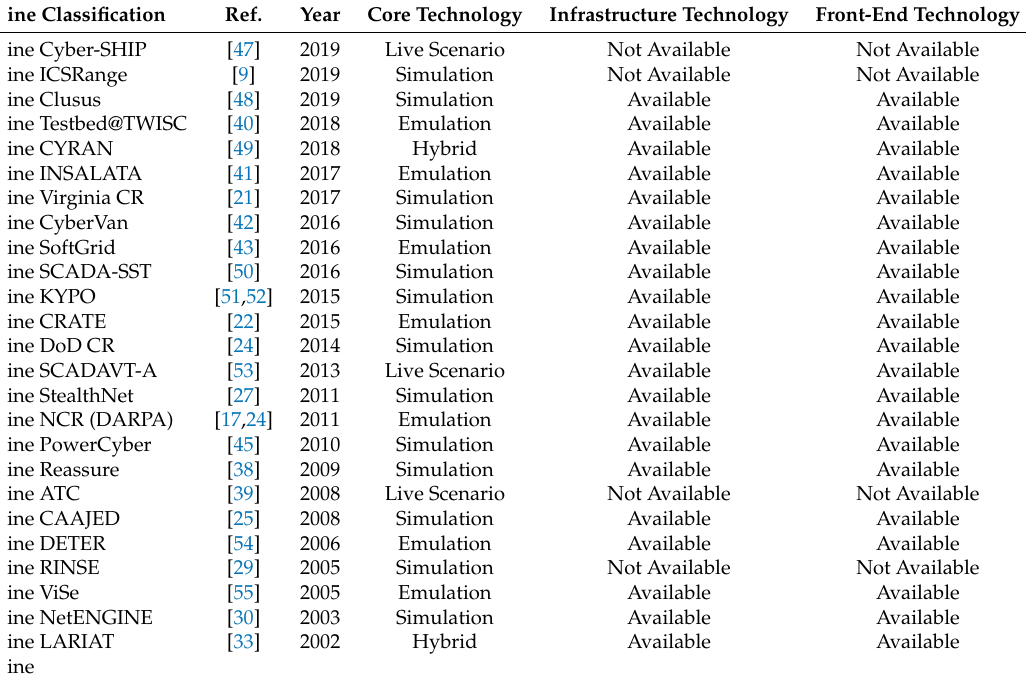
Table 2. CR and TB Technologies.